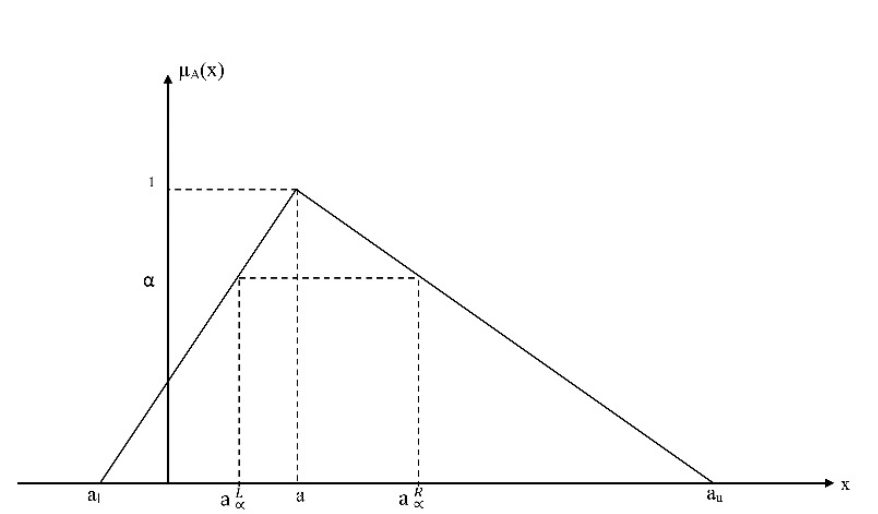
Figure 3. Triangular fuzzy number [15].